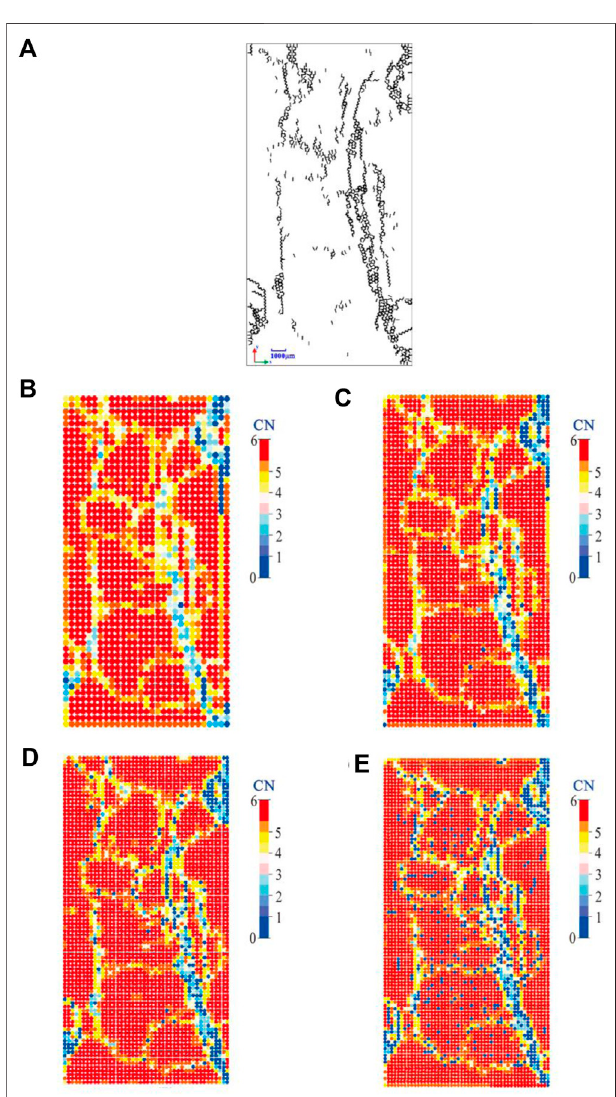
FIGURE 12 | Rock sample with microcracks (A) with estimated coordination number (CN) maps for four different-radius measuring